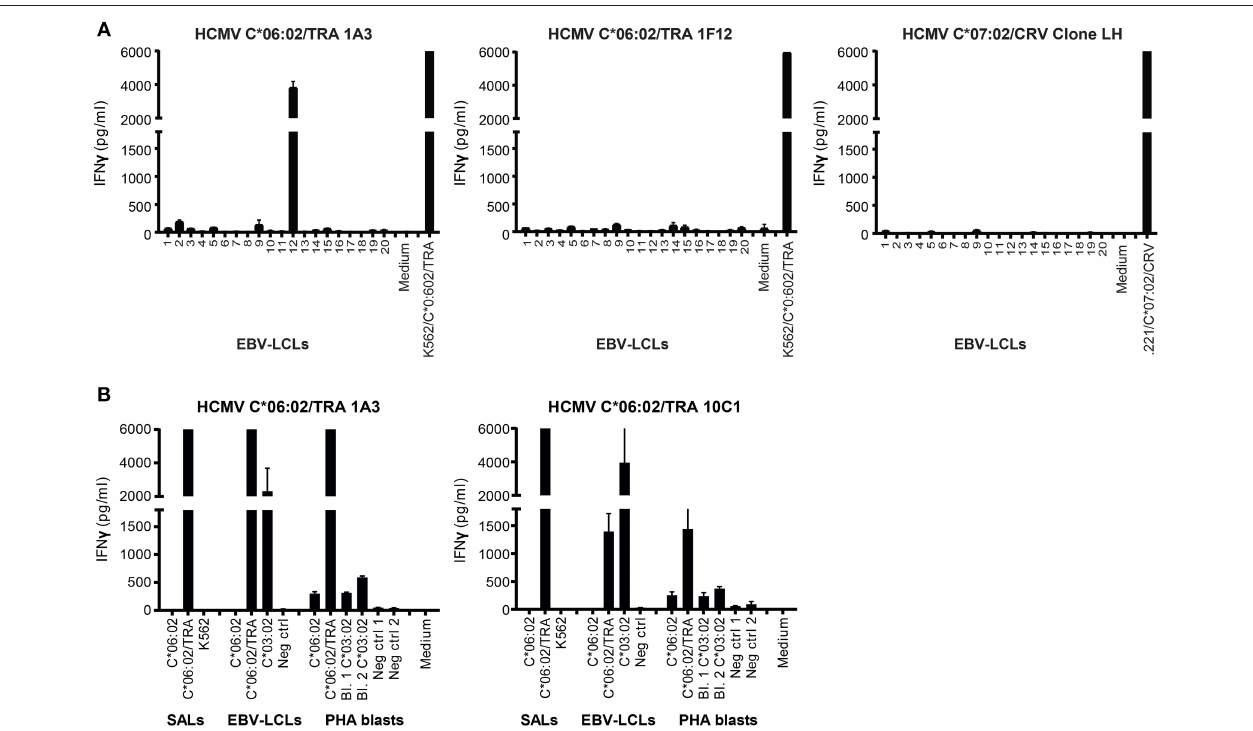
FIGURE 4 | Alloreactivity of HCMV C*06:02/TRA T cell lines against HLA-C*03:02. (A) Two HCMV C*06:02/TRA T cell lines (1A3 shown) and two T cell clones (1F12 shown), and HCMV C*07:02/CRV T cell clone LH were stimulated with a panel of EBV-LCLs after which IFN γ production was measured. (B) Three HCMV C*06:02/TRA T cell lines (1A3 shown) and five T cell clones (10C1 shown) were stimulated with EBV-LCLs and PHA blasts, obtained from two different donors, expressing the recognized allo-HLA-C*03:02 allele and the virus-specific restriction allele HLA-C*06:02 loaded with viral peptide as a positive control. SALs expressing HLA-C*06:02 loaded with viral peptide were also included as a positive control. The range of the ELISA standard curve: 5–5120 pg/ml. Bars represent duplicate values with standard deviation of the mean.